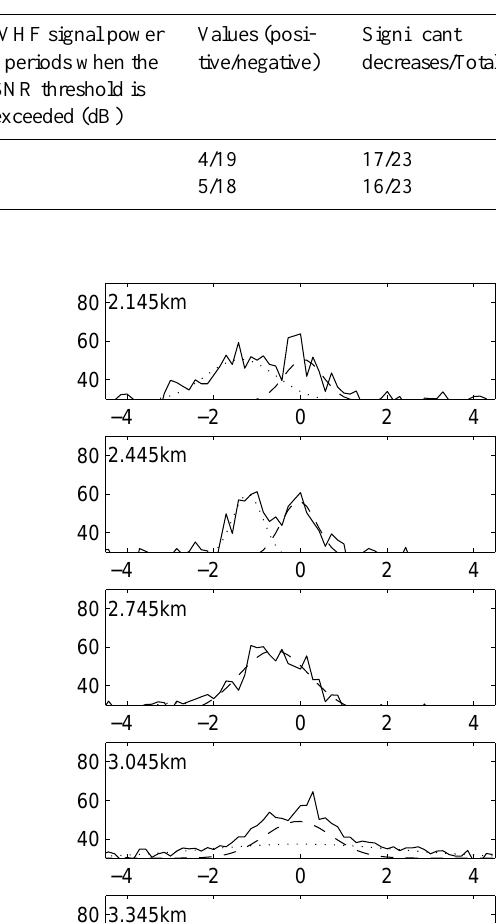
Table 3. The mean VHF signal power is shown averaged over the 2 to 4 km height range during periods where the UHF signal-to-noise ratio was greater or less than the thresholds indicated. The number of positive and negative changes are also shown in the VHF signal power as well as the number of days where a significant decrease in signal power was associated with large UHF signal-to-noise ratios.